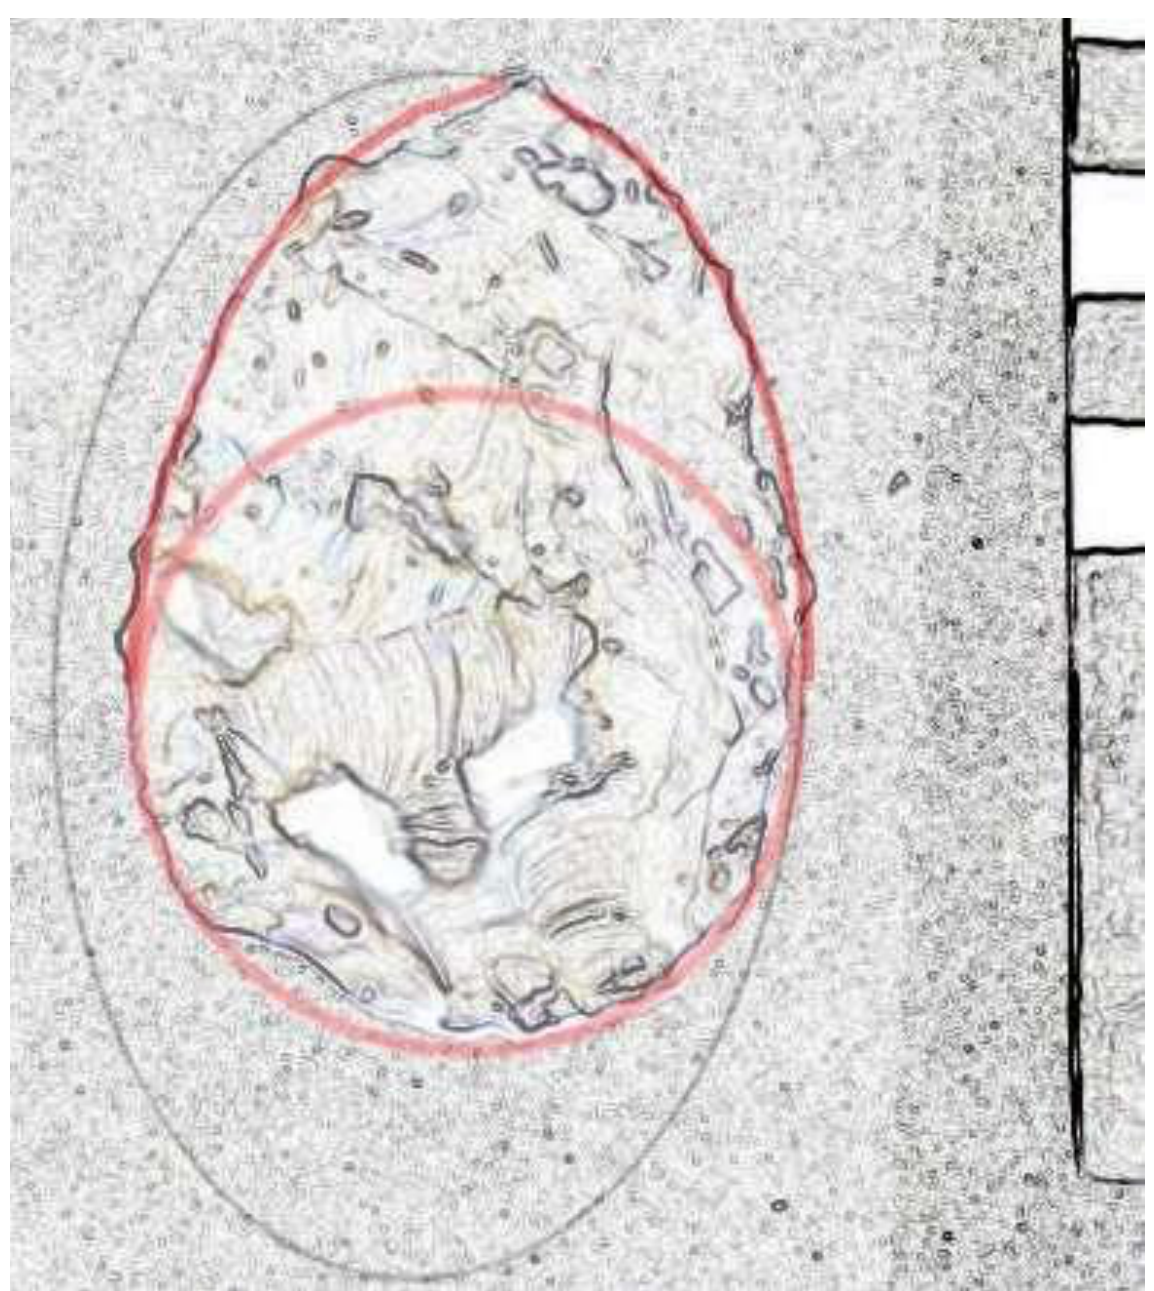
Figure 5. Specimen